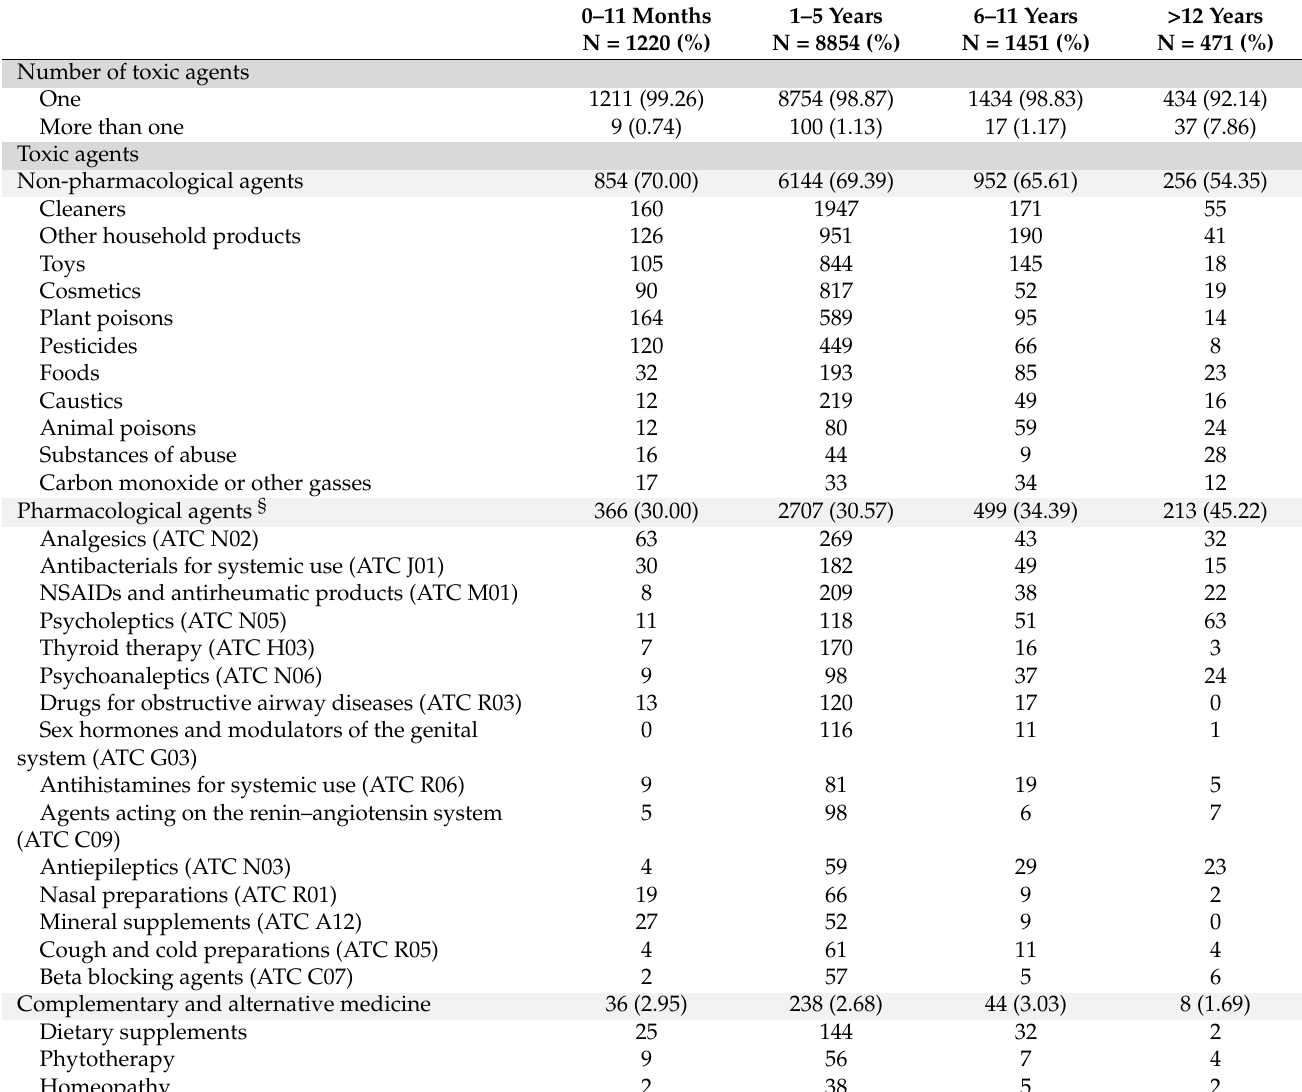
Table 2. Description of toxic agents according to age classes (N =